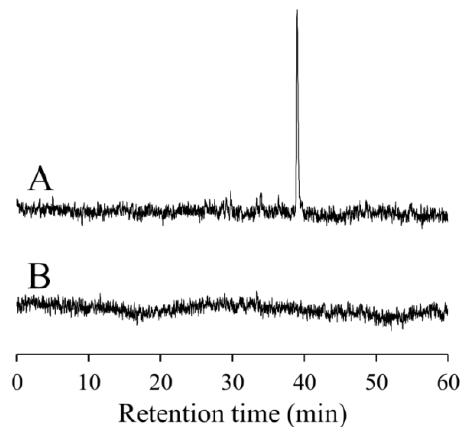
Figure 2. High performance liquid chromatography (HPLC)-electron spin resonance (HPLC-ESR) analyses of the standard D O reaction mixture (I). The reaction and 2 HPLC-ESR conditions are described in the Experimental Section. The total reaction volume was 1.5 mL. HPLC-ESR analyses for ( A ) the standard D O reaction mixture (I); 2 and ( B ) the standard D O reaction mixture (I) with 2 mM CA. 2